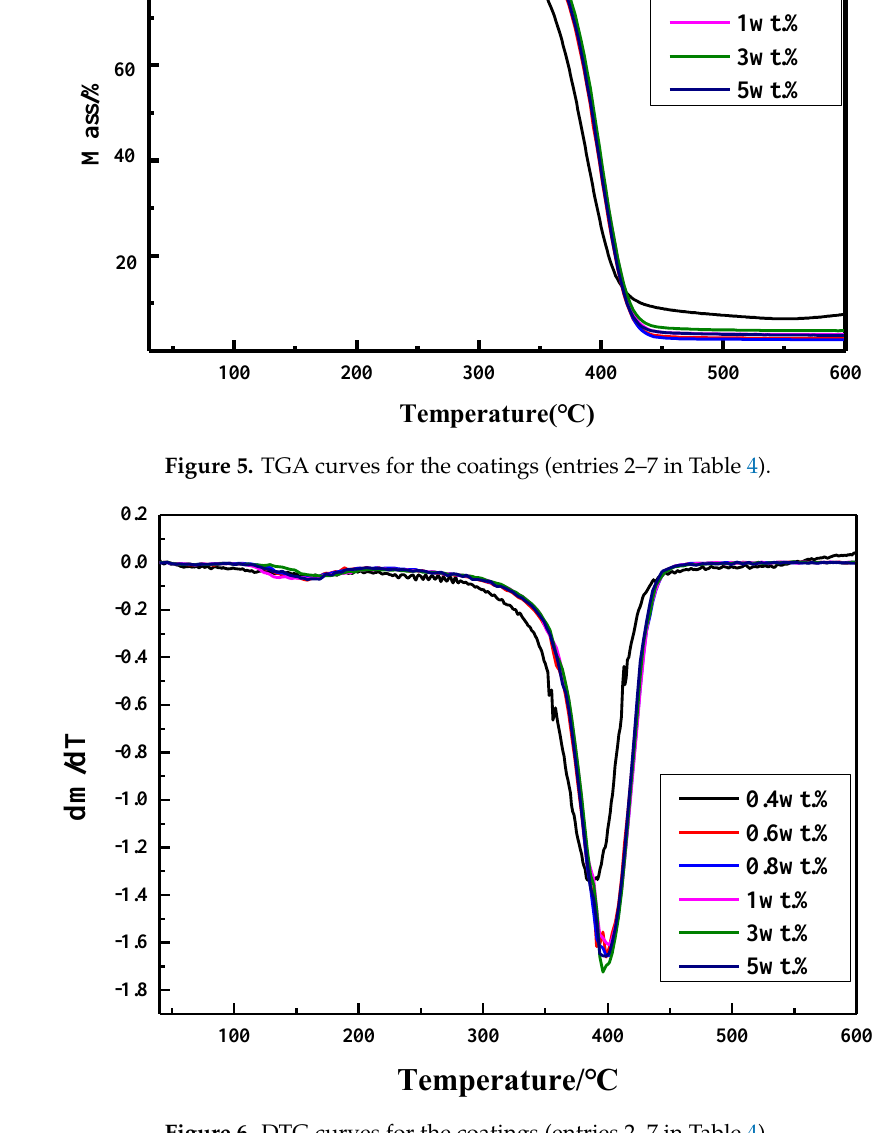
Figure 6. DTG curves for the coatings (entries 2–7 in Table 4).